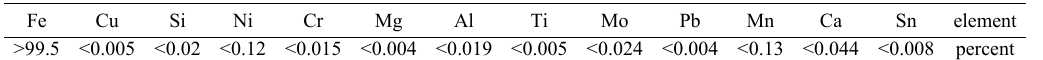
Table 1. The elemental analysis of bare synthesized